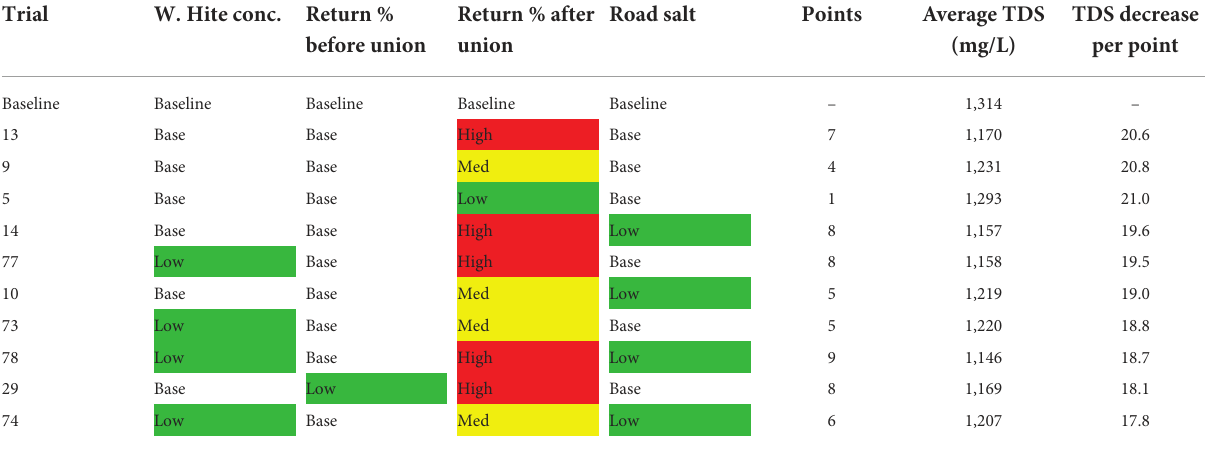
TABLE 4 Top 10 efficient agricultural salt management trials for the months